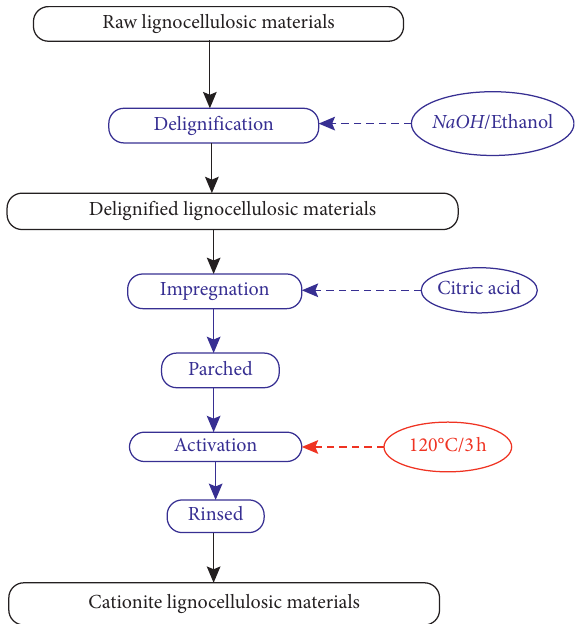
Figure 4: Modification procedure of the lignocellulosic materials with CA in parched condition [35,